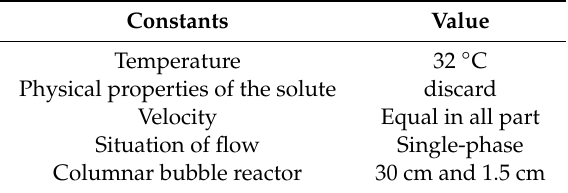
Table 1. Constants and values of the parameters inputted.